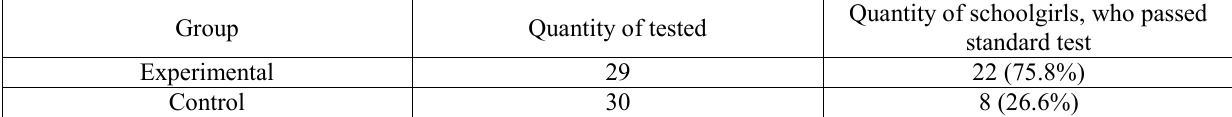
Quantity of schoolgirls, who passed standard test “running high jump” Quantity of